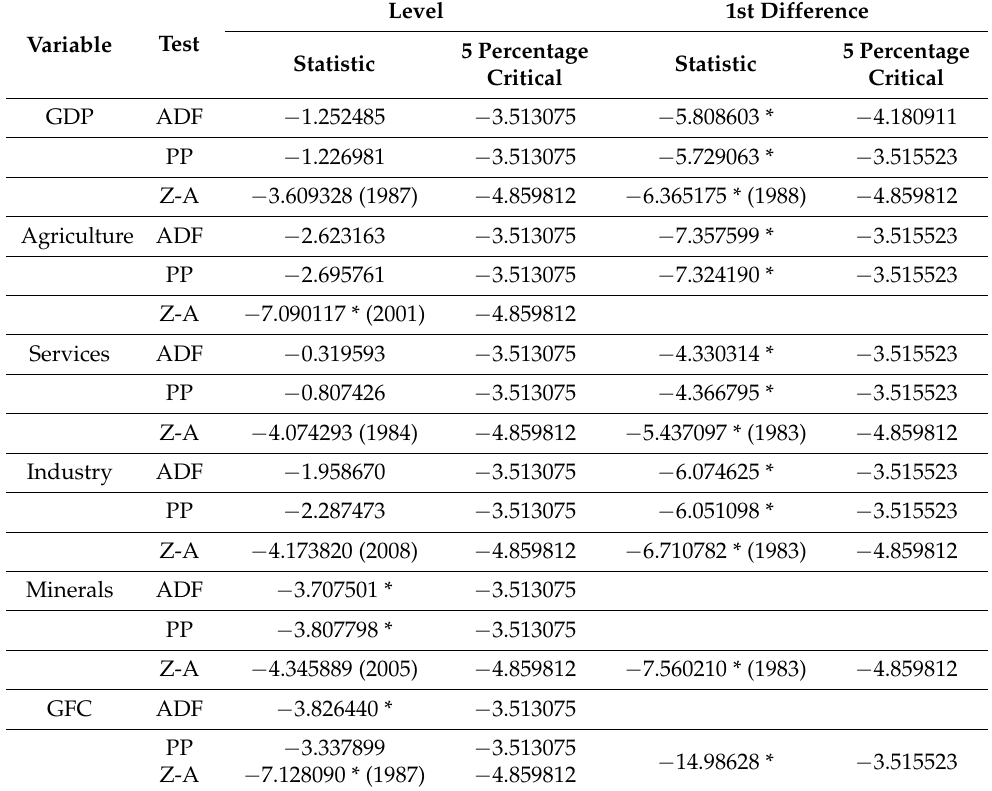
Table 4. Unit root